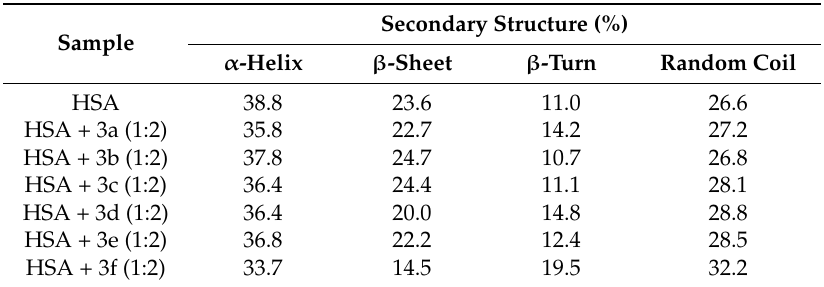
Table 8. Conformation changes in the secondary structure of HSA with and without PDQL. Sample